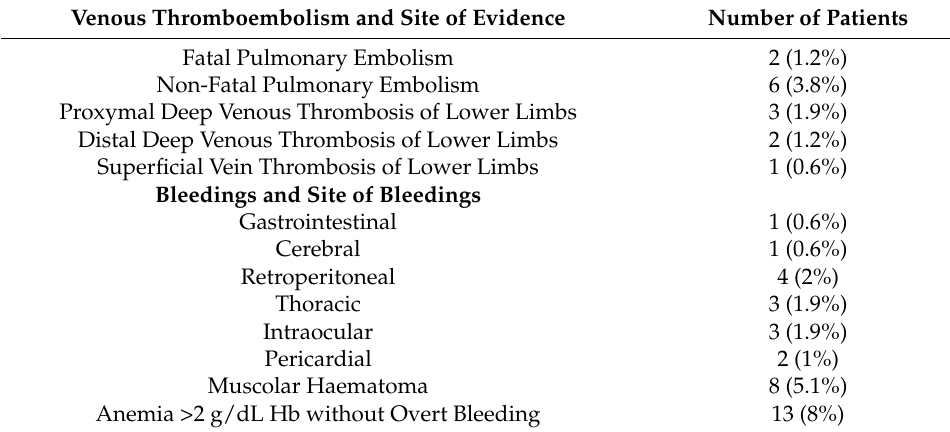
Table 2. Thrombotic and haemorrhagic events in the overall study cohort.